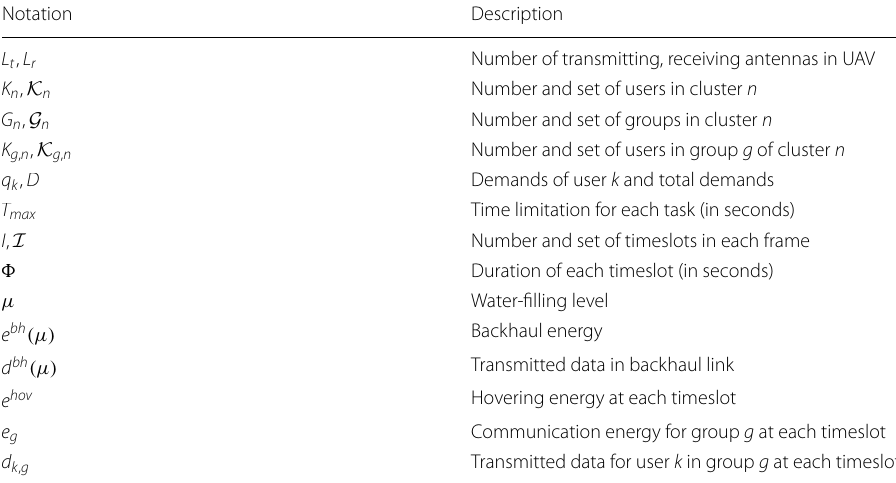
Table 1 Summary of symbols and notations